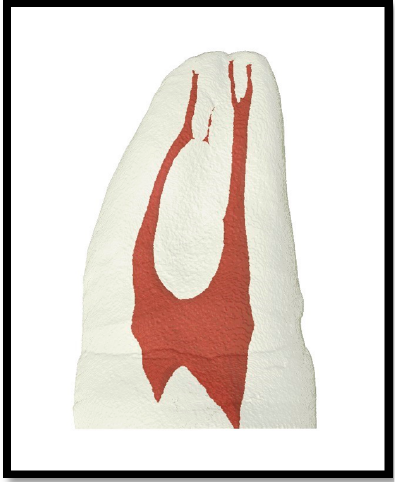
Figure 8. Micro-CT image showing the additional canal configuration (2-3).